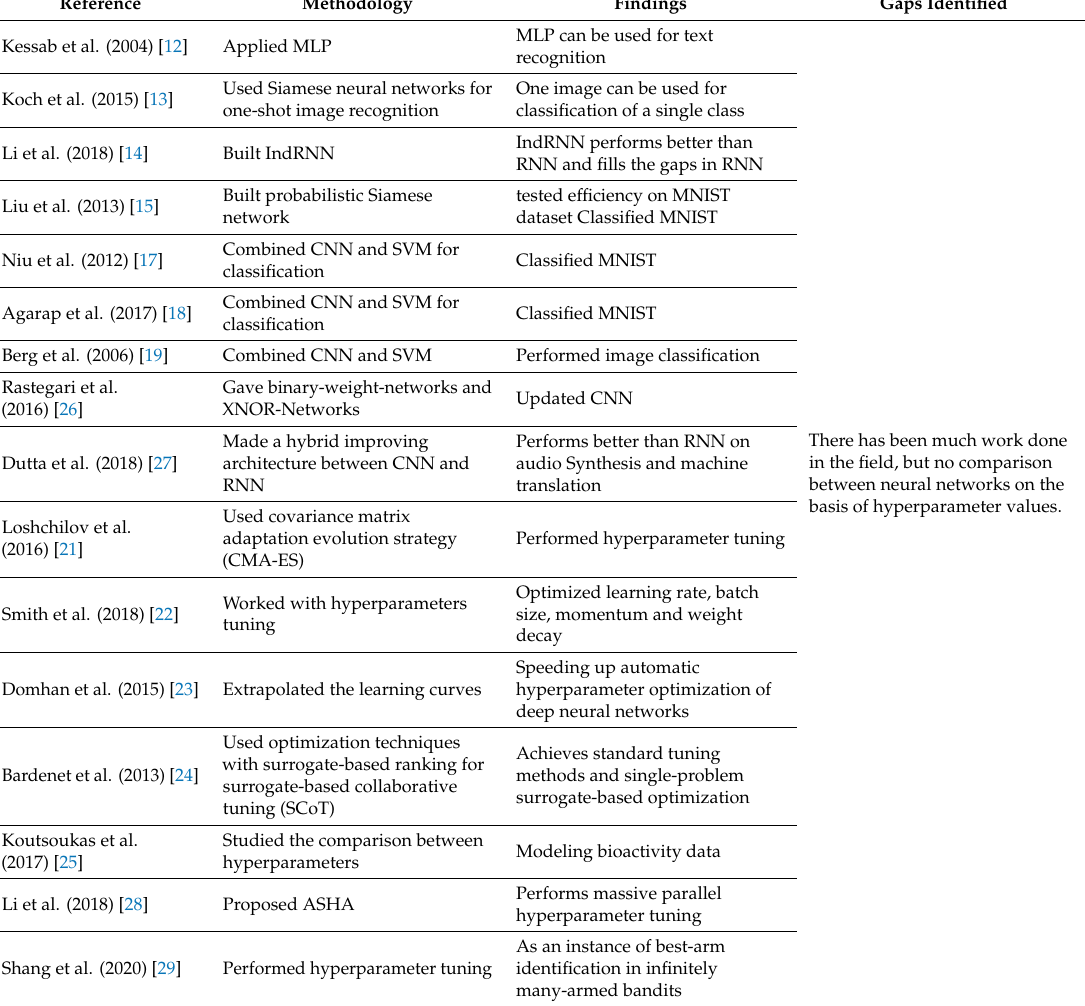
Table 1. Comparison table of previous methodologies.